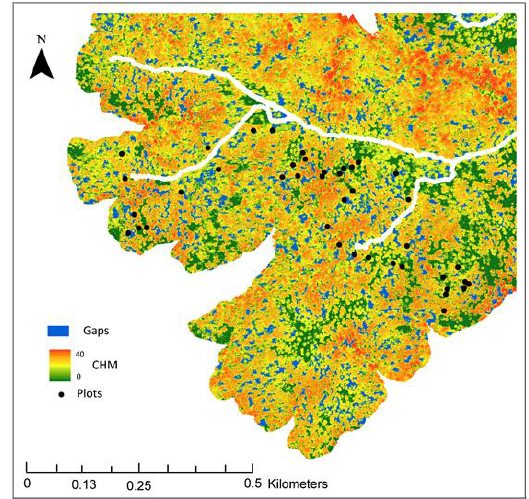
Figure 5. Map of a Pinus palutris dominated stand situated in Reed Brake Research Natural Area, Oakmulgee Ranger District, Talladega National Forest, Alabama, USA. The canopy height model displayed was derived from LiDAR data, with detected canopy gaps in blue. Black dots represent canopy gap sampling plots. Note that our maximum gap size threshold was 300 m 2 . The white area within the canopy height model is the 10 m buffer around abandoned skid